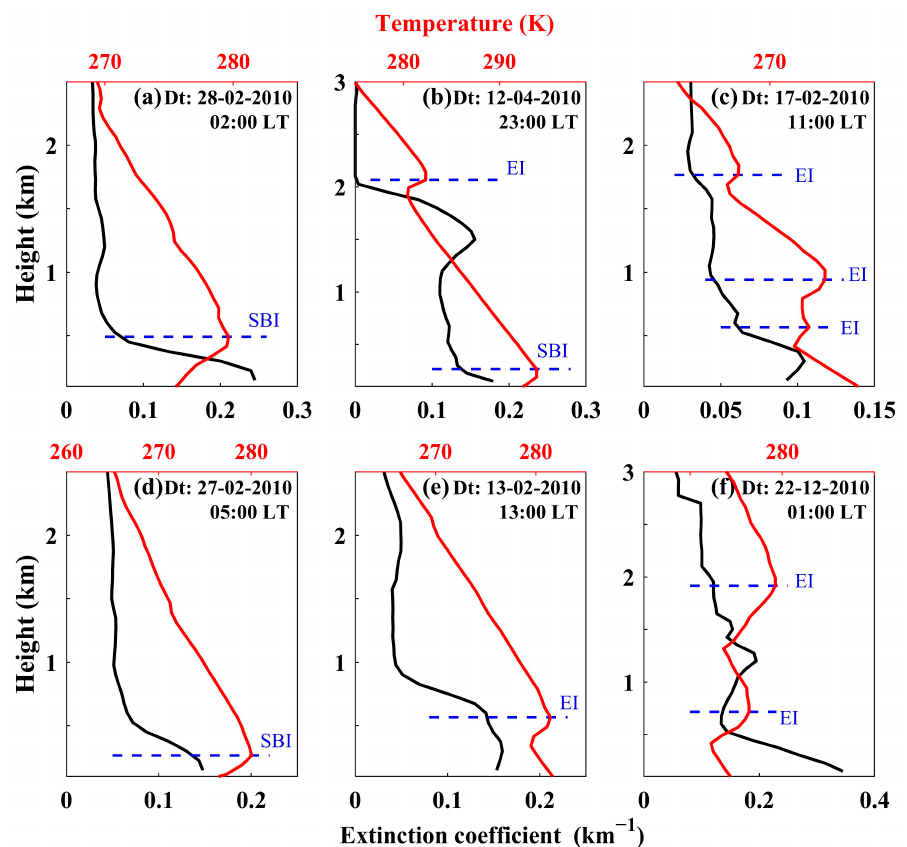
Figure 6. The vertical profile of extinction coefficient (black) and temperature profile (red) observed on ( a ) 8 February 2010 at 02:00 local time, ( b ) on 12 April 2010 at 23:00 local time, ( c ) on 17 February 2010 at 11:00 local time, ( d ) on 27 February 2010 at 05:00 local time, ( e ) on 13 February 2010 at 13:00 local time, and ( f ) on 22 December 2010 at 01:00 local time over the Southern Great Plains site. Blue dotted lines represent the different layer height.